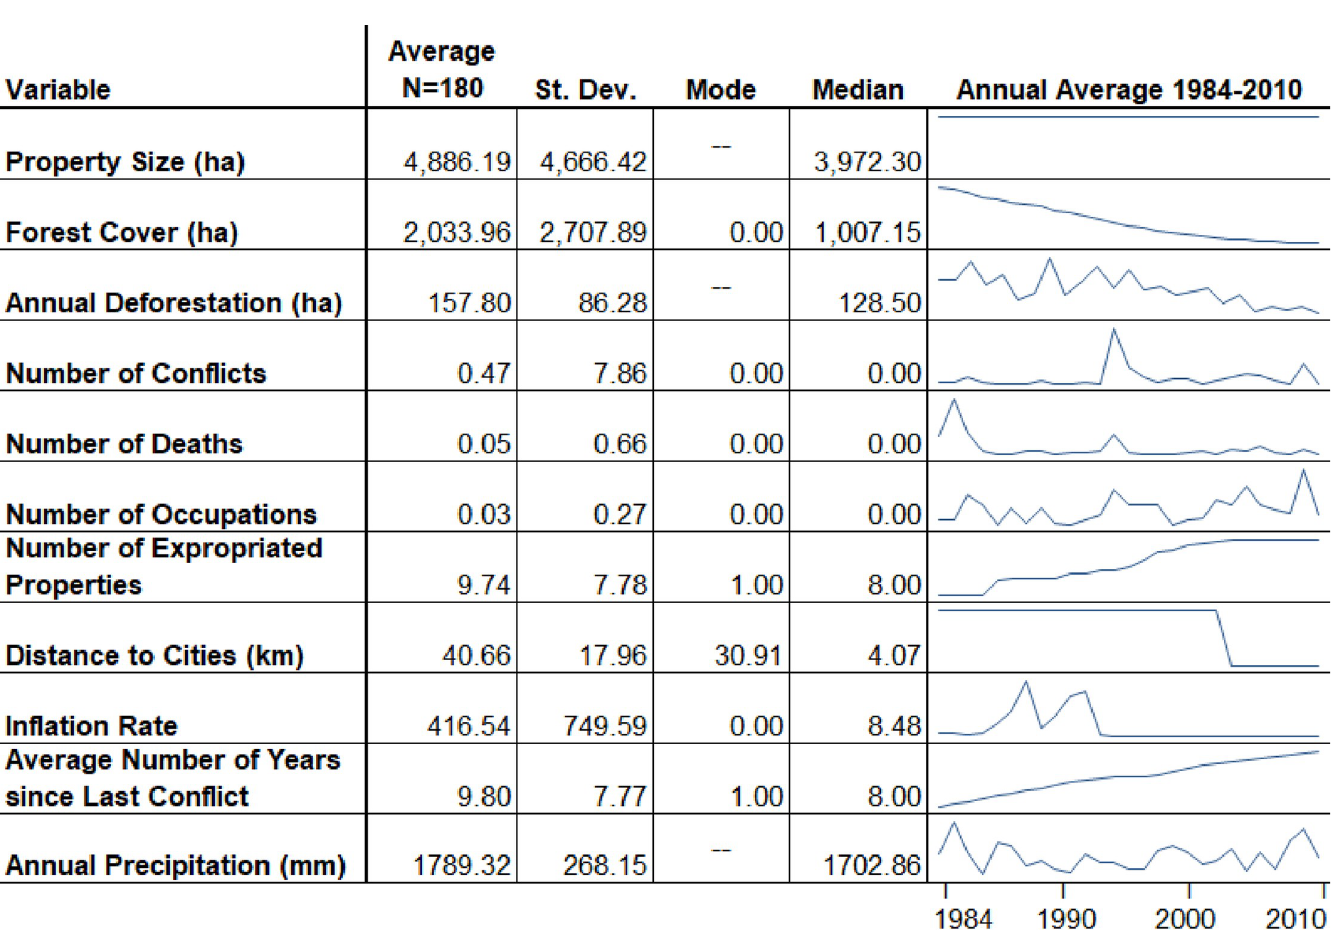
Fig 3. Summary statistics for important characteristics of BNP